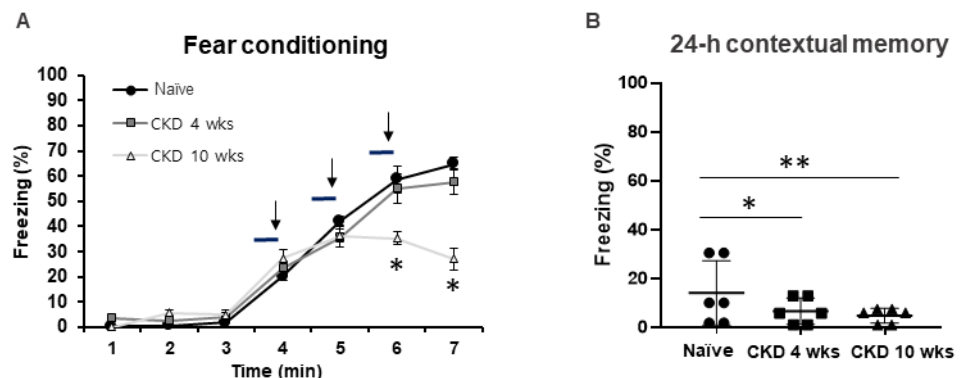
Figure 3. Impairment of contextual fear memory in CKD 4, 10- wk rats. Contextual and cued fear conditioning and 24-h retrieval of contextual memory were performed ( A , B ) No differences in classical fear conditioning were observed in CKD 4-wk rats, although CKD 10-wk rats spent a significantly lower percentage of time freezing compared with naïve rats ( A ). The horizontal line indicates the duration of a tone (28 s), and the vertical arrow indicates the time of foot shocks (2 s). Deficits in contextual fear memory were observed in the CKD rats ( B ). Data are presented as means ± SEM. * p < 0.05, ** p < 0.01 by one-way analysis of variance, contextual fear conditioning: n =